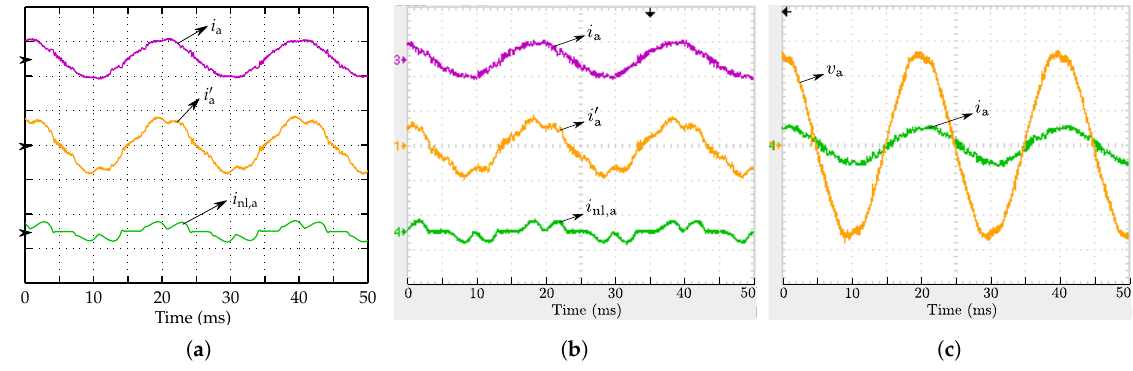
Figure 9. Simulation and experimental results with a 250W non-linear load. ( a , b ) Grid line current i a , shunt converter ac line current i 0 a and load line current i nl,a [5A/div]. ( c ) Experimental grid line-to-ground voltage v a [60V/div] and line current i a [5A/div].